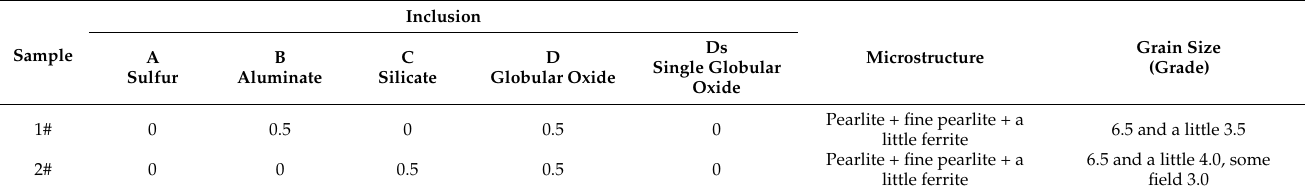
Table 5. OM test